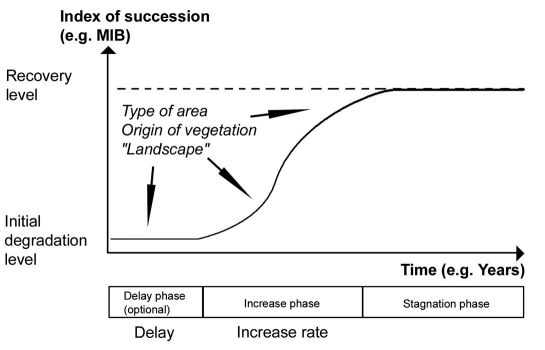
Schematic illustration of the model. Succession starts from an ‘initial degradation level’, followed by a facultative ‘delay phase’ (characterized by the time of ‘delay’). The optional ‘delay phase’ is followed by an ‘increase phase’ (characterized by the ‘increase rate’), and a ‘stagnation phase’ in which the succession process runs towards a ‘recovery level’. The type of area, origin of vegetation, and landscape-related aspects are assumed to influence the trajectory of succession.